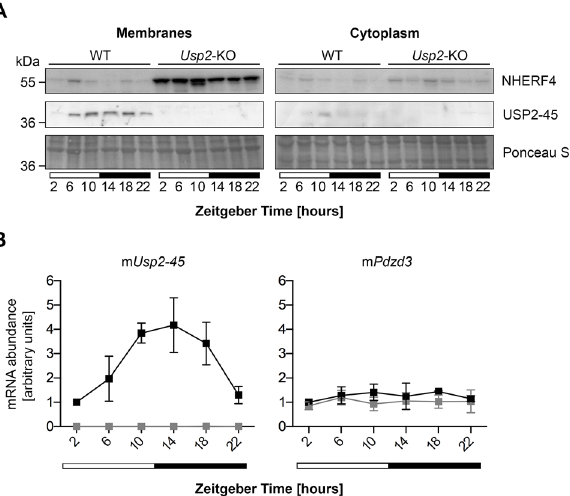
Fig 5. The lack of USP2-45 leads to a loss of NHERF4 rhythm at the protein level in the membrane compartments of small intestine mucosa. A : Mucosa of the whole small intestine was dissected at the indicated time points around the clock and membrane and cytoplasmic protein extracts were prepared from the remaining tissue. Protein extracts were analysed by immunoblotting with anti-USP2-45 N-term and anti- NHERF4 antibodies. Ponceau-Red S staining of the membrane was used as loading control. Data are western blots from one representative series of mice out of three. B : RNA was extracted from mid-jejunum and the mRNA levels of the corresponding proteins were analysed by semi-quantitative real-time PCR (qPCR). Data are presented as mean ± SD of three independent animal series. WT: black line, Usp2 -KO: grey line.